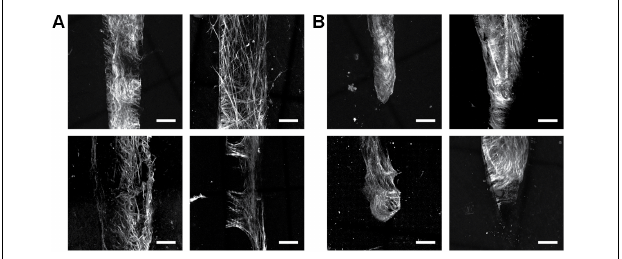
FIGURE 1 | Healthy brain tissue is largely devoid of fibrillar collagen. Second Harmonic Generation (SHG) imaging of mouse brain tissue shows virtually no fibrillar collagen (green, 890 nm excitation 445/40 nm emission) within the parenchyma. Collagen fibers can be seen surrounding the cortex and within and between ventricles. Multiphoton induced autofluorescence (red, 890 nm excitation, 592/100 nm emission, likely FAD) was recorded to observe gross anatomical features of the tissue. Scale bar = 1 mm.